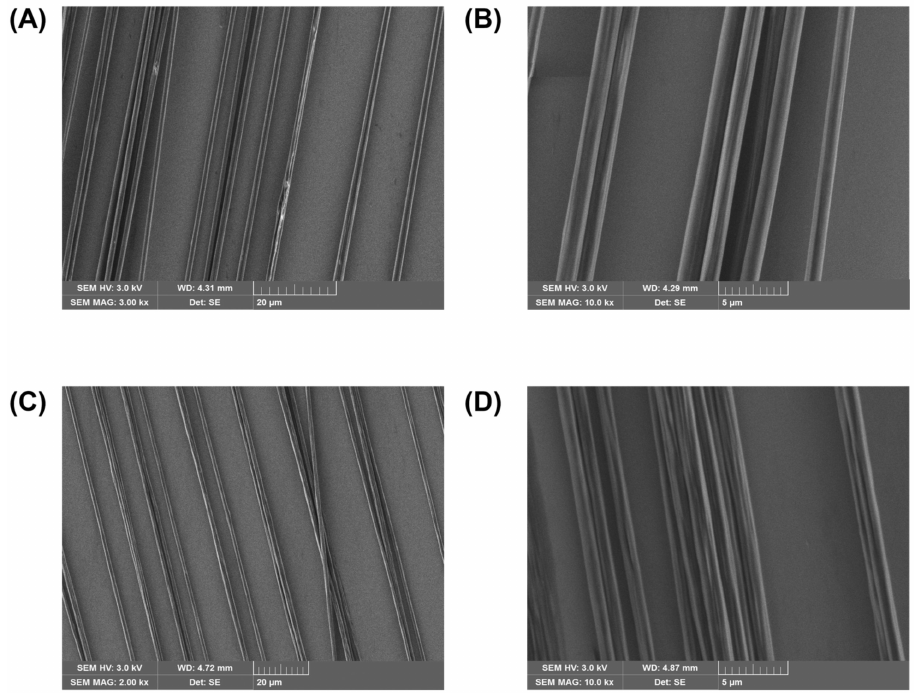
Figure 1. SEM micrographs of P3HT:PEO nanofibres: panels ( A , B ) as deposited; panels ( C , D ) P3HT samples after removal of